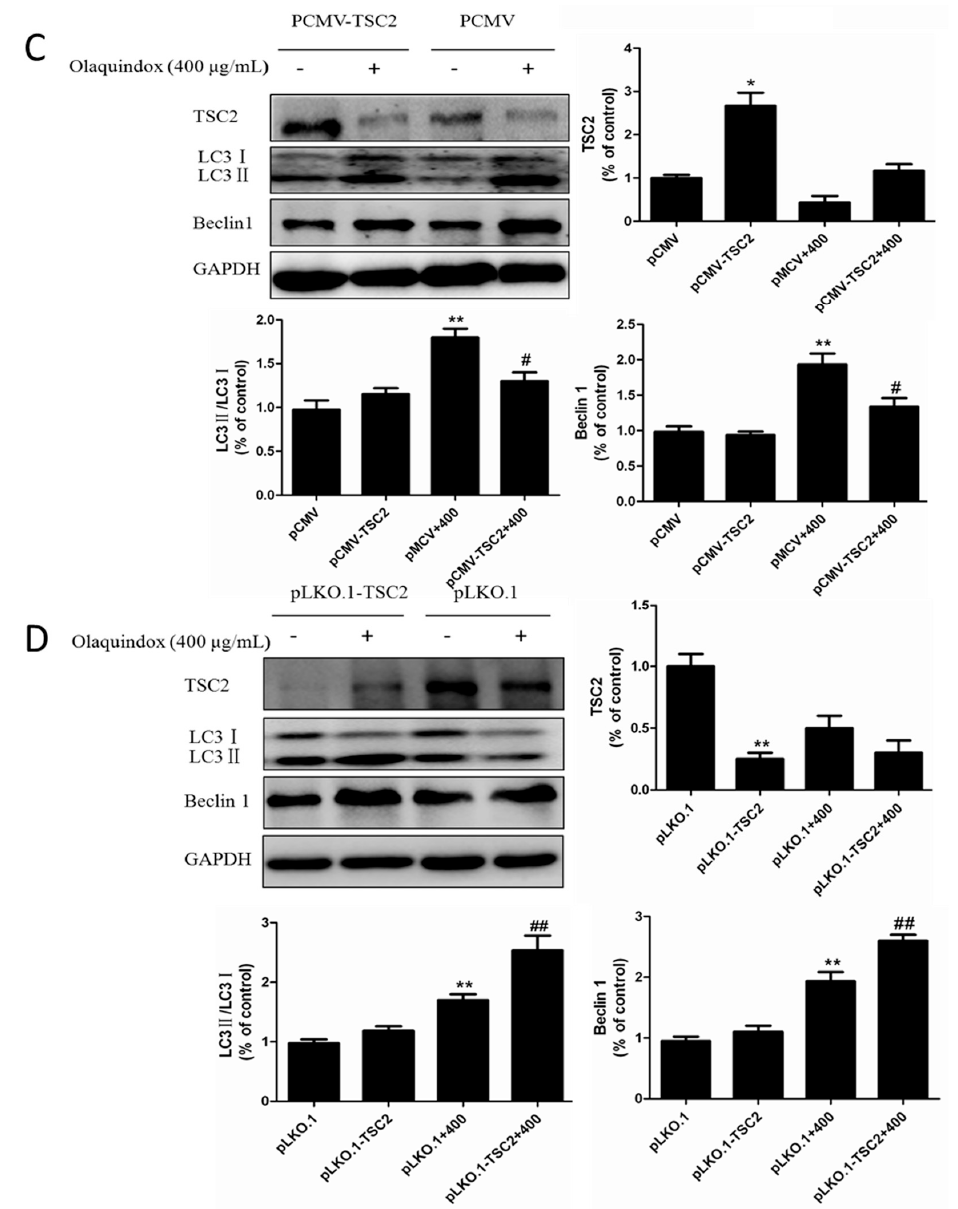
Figure 5. Effect of TSC2 on olaquindox-induced autophagy. ( A ) Expression of TSC2 treated with olaquindox (0, 200, 400, 800 μ g/mL) for 24 h was detected by western blotting analysis; ( B ) Cells treated with 800 μ g/mL olaquindox for different time points (0–24 h) and expression of TSC2 was detected by western blotting; ( C ) Overexpression of TSC2 inhibited olaquindox-induced the expression of LC3II/LC3I and Beclin 1; ( D ) Knockdown of TSC2 enhanced olaquindox-induced the expression of LC3II/LC3I and Beclin 1. GAPDH was used for loading control. All data represents means ± SD from three independent experiments. * p < 0.05, ** p < 0.01, compared to the control pCMV or pLKO.1 transfected cells; # p < 0.05, ## p < 0.01, compared to olaquindox-treated pCMV or pLKO.1 transfected cells.